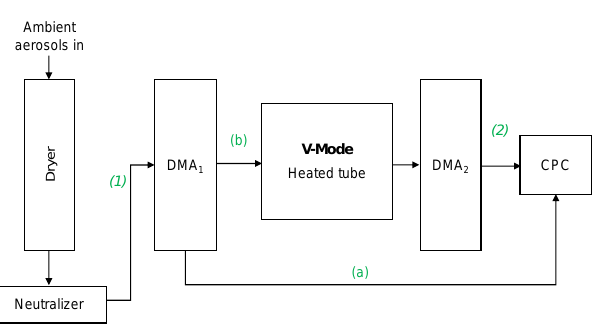
Figure 2. Examples of particle size distributions of (a) ambi- ent aerosols before entering DMA 1 and (b) residuals of the size- selected particles ( D 0 ) after heating at 300 ◦ C. The distributions in (a, b) correspond to (1) and (2) in Fig. 1, respectively. Residuals are divided into three groups – LV (blue), MV (green) and HV (red) – based on their VSF. CV (purple) and VM (orange) are vaporized and hence not measured as residuals. VM appears as coating for illus- tration purposes only. It does not necessarily reflect the morphology of the